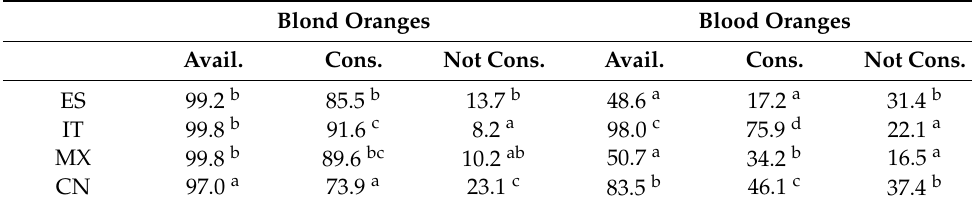
Table 2. Percentage of participants from each country (ES-Spain, IT—Italy, MX—Mexico and CN— China) who stated that blond oranges/blood oranges were available in their habitual purchase place (Avail. column). The “Cons.” column indicates the percentage of them who stated consuming oranges habitually, and “Not Cons.” was the percentage who stated not consuming them. Blond Oranges Blood Oranges Avail. Cons. Not Cons. Avail. Cons. Not Cons. ES